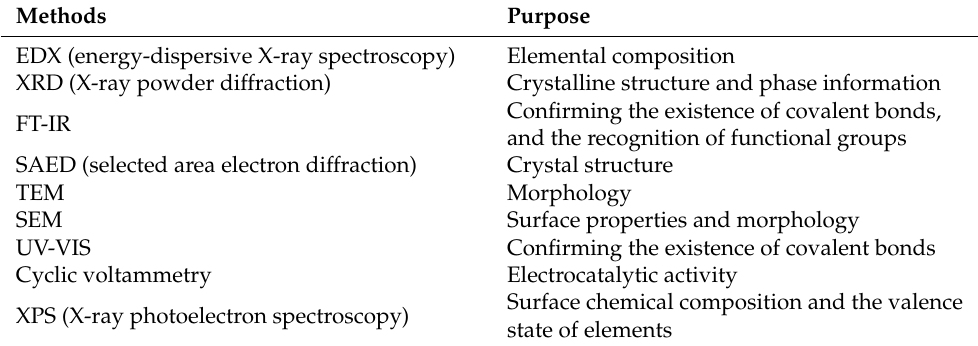
Table 1. Commonly used characterization methods in developing nanozyme-based amperometric